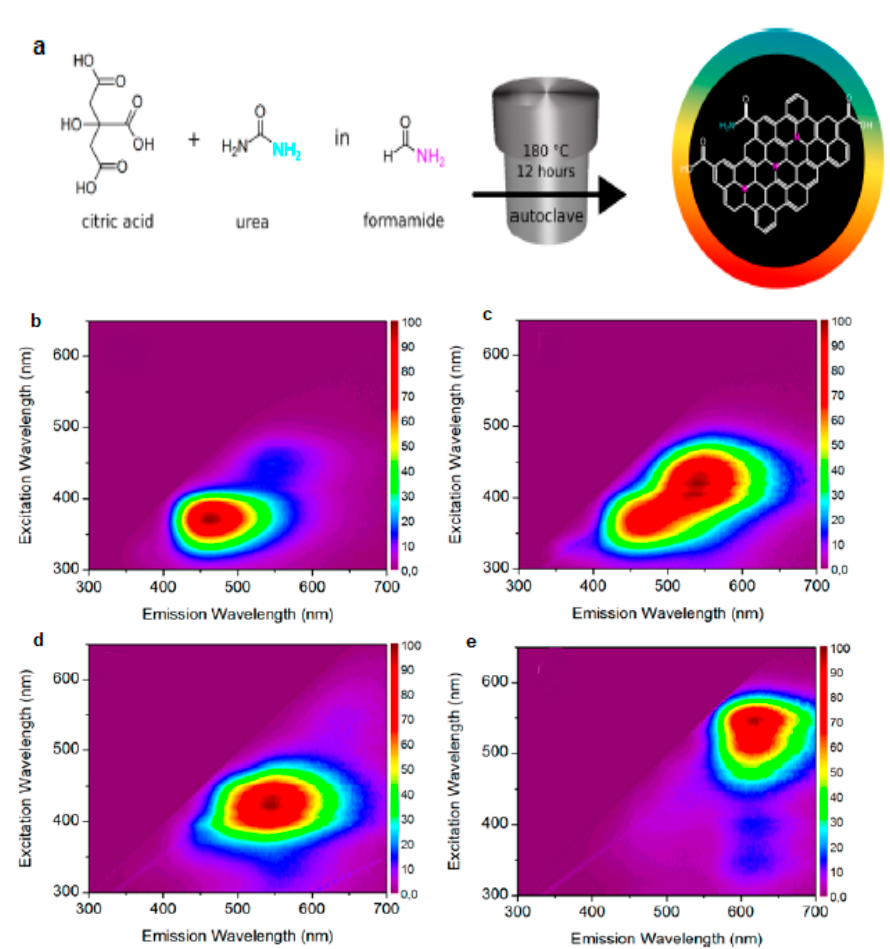
Figure 1. ( a ) Schematic illustration of the synthesis followed to generate a family of C-dots from CA/urea in formamide. ( b − e ) Fluorescence excitation − emission map of: ( b ) b-C-dots, ( c ) g-C-dots, ( d ) y-C-dots and ( e ) r-C-dots. Reprinted (adapted) with permission from [39]. Copyright 2021 American Chemical Society.